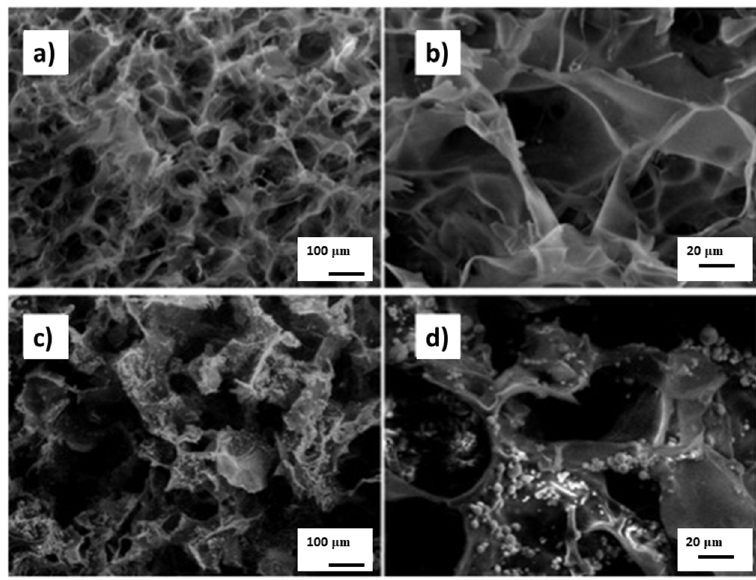
Figure 2. SEM of scaffolds. ( a , b ) Pure collagen. ( c , d ) Col/mHA (collagen/hydroxyapatite-microsphere). Scale bars: 100 μ m ( a , c ), 20 μ m ( b , d ). Reprinted from [44] with permission from Elsevier.